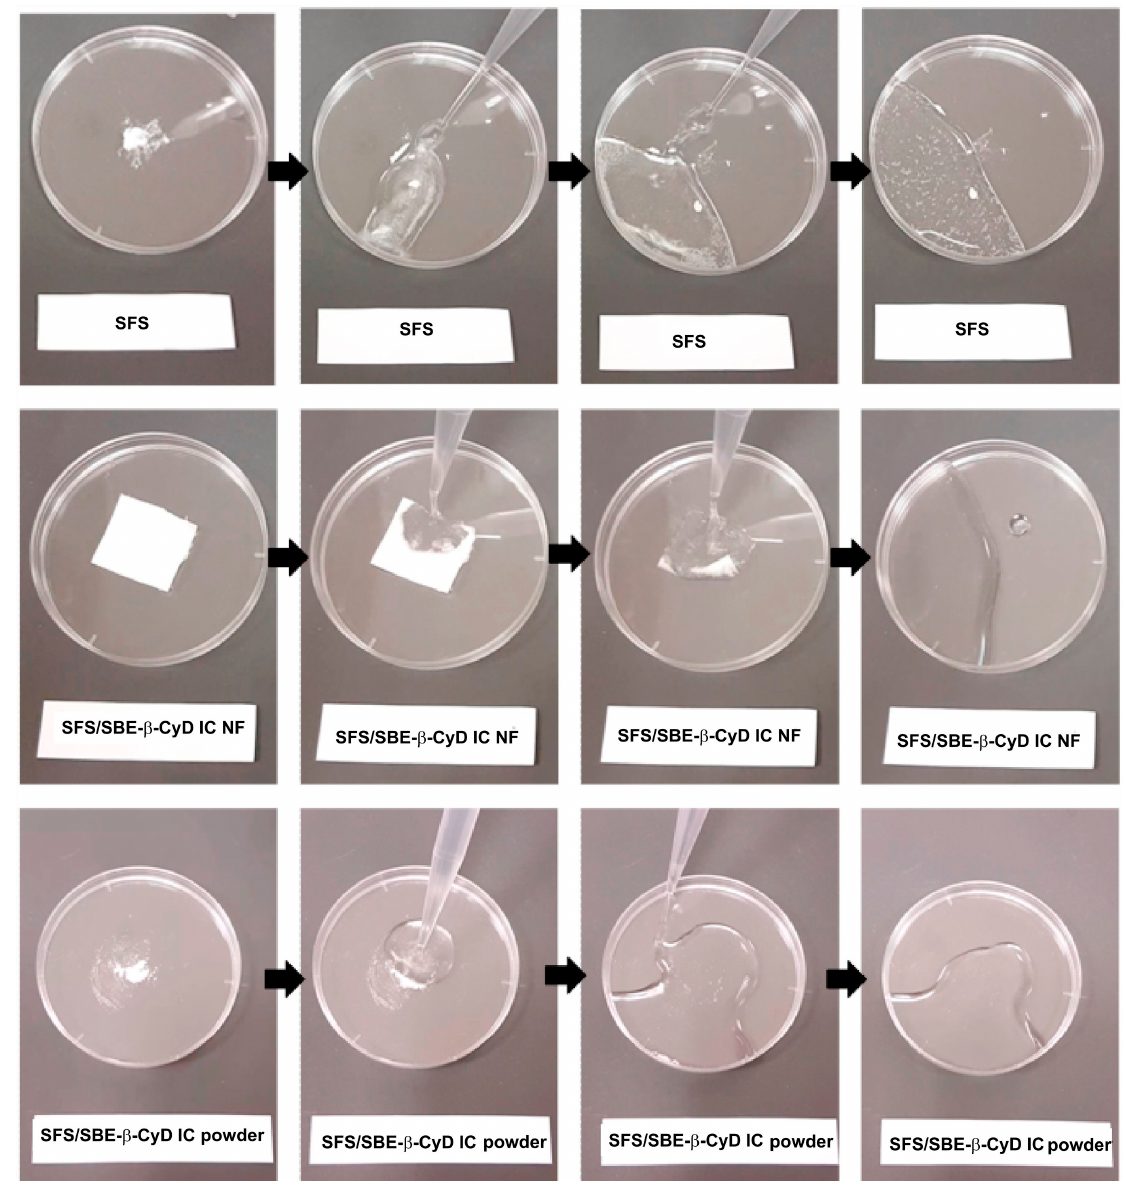
Figure 7. Typical water-solubility of the drug loaded polymer-free CyD fibers. The representative photos of the SFS and SFS/ SBE 7 - β -CyD IC powder and SFS/ SBE 7 - β -CyD IC nanofibers on exposure to water. The figure was reproduced from [179] with the permission of Elsevier, 2017.